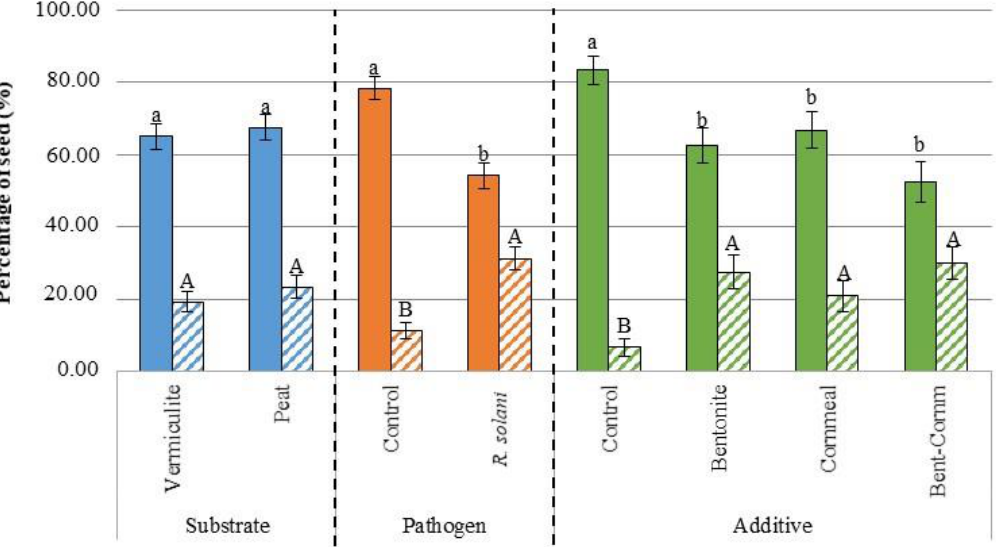
Figure 1. Germination percentage and removed seeds percentage after 24 days of sowing for substrates, pathogen and additives. Blue colour represents the substrates; orange colour represents the presence or absence of R. solani ; green colour represents the types of additives; solid colour represents germination and with striped colour represents removed seeds. Bars of the same colour followed by different letters (small letter for germinated seeds and capital letters for removed seeds) are significantly different ( p ≤ 0.01).